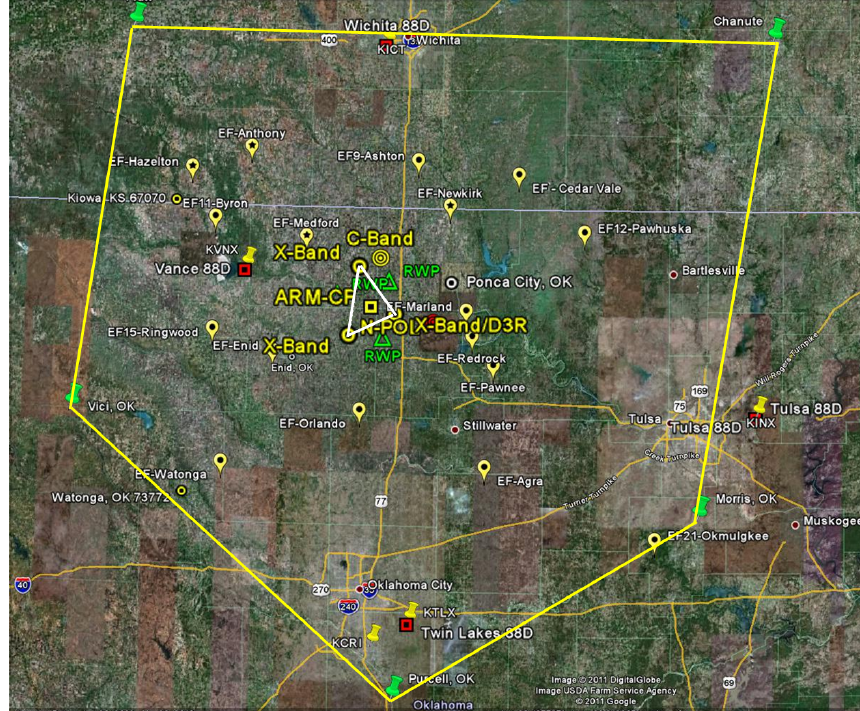
Figure 1. MC3E operations map: around the ARM central facility (small yellow square) are arrayed the X-band radars (white triangle), the sounding array (large yellow pentagon), and the C-band scanning ARM precipitation radar (C-SAPR) (yellow bullseye symbol); figure courtesy of Michael